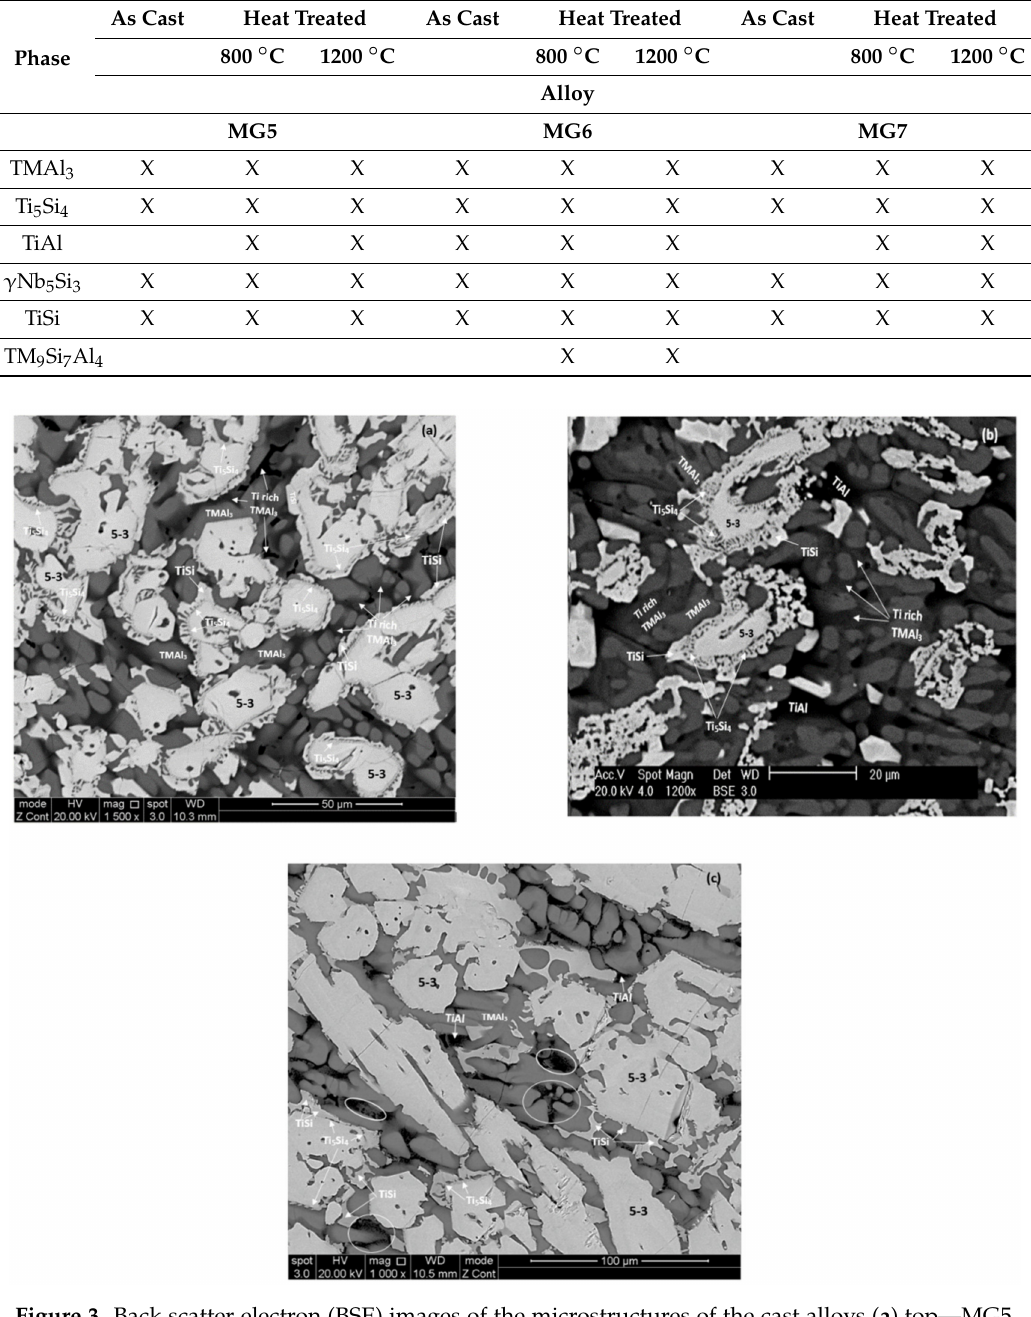
Table 1. Phases in the microstructures of the cast and heat treated alloys MG5, MG6 and MG7 [3] confirmed by XRD and quantitative EDS.